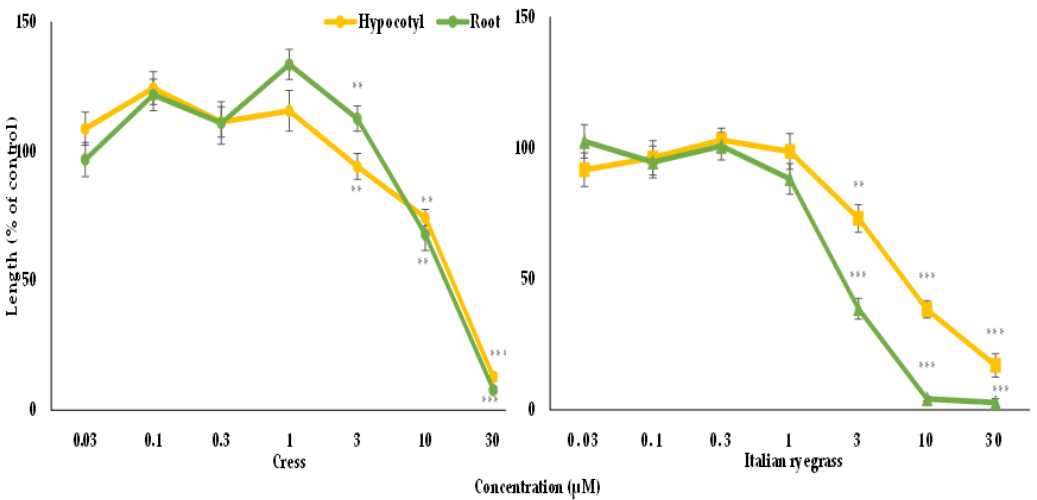
Figure 6. Effect of gallic acid on the seedling’s growth of cress and Italian ryegrass: mean ± SE from the two separate experiments with three replications (10 seedlings for each replication) for every experiment that is displayed. Asterisks signify important variations between treatments and control: ** p < 0.01, and *** p < 0.001 (ANOVA one-way and LSD test by post hoc). Table 2. The I 50 values of vanillic acid and gallic acid from Wedelia chinensis against the shoot and root The I 50 values of vanillic acid against cress shoot and root were 0.04 and 0.05 mM, respectively, growth of cress and Italian ryegrass. Vanillic Acid Tested Species